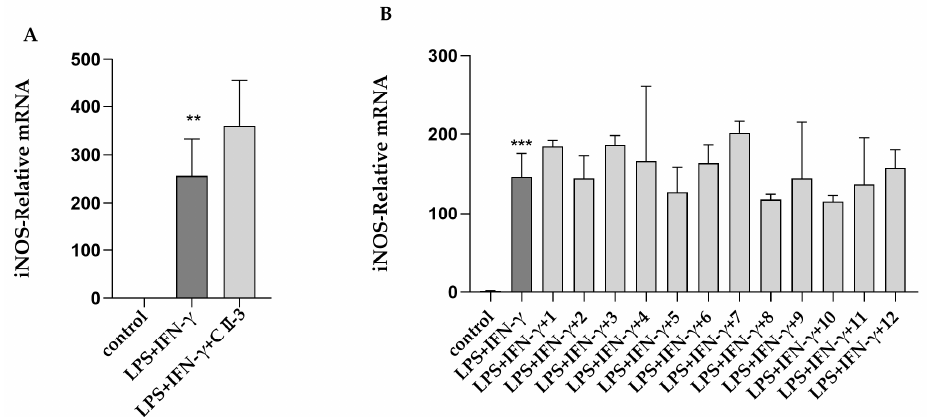
Figure 3. Expression effects of CII-3 and 12 compounds on iNOS in LPS and IFN- γ -induced RAW264.7 cells. iNOS expression affected by CII-3 ( A ) and 12 compounds ( B ). ** p < 0.01 and *** p < 0.001 vs. the control group.